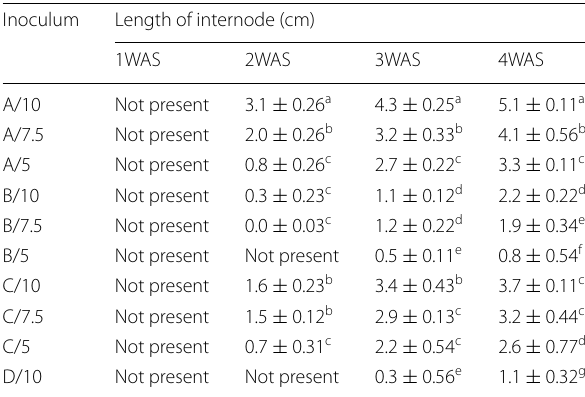
Table 6 Effect of PSB inoculum on in vitro rice length of internode